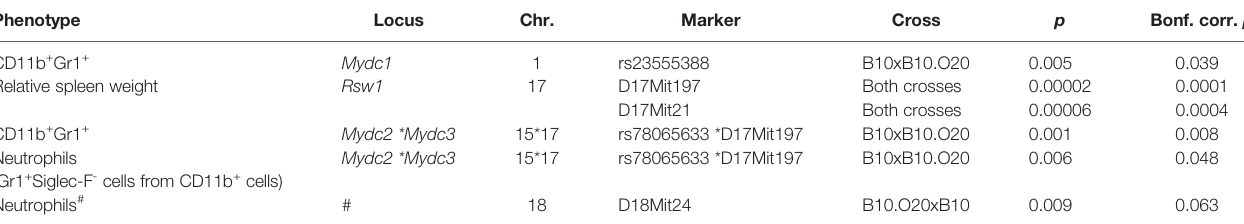
FIGURE 2 | Positions of the loci that control relative spleen weight and frequencies of myeloid-derived subpopulations in spleen of the strain B10.O20. The regions of C57BL/10 and O20 are represented as black and white, respectively; the boundary regions of undetermined origins are shaded. The identi fi ed loci Mydc1-3 and Rsw1 and potential candidate genes are indicated. Only the markers or SNPs de fi ning the boundaries of O20-derived segments and markers that were tested for linkage are shown (except syntenic D17Mit10). Bold in box — signi fi cant linkage, regular font in box — suggestive linkage. TABLE 2 | Summary of loci controlling spleen cell subsets in B10.O20. Chr. Marker Cross p Bonf. corr. p